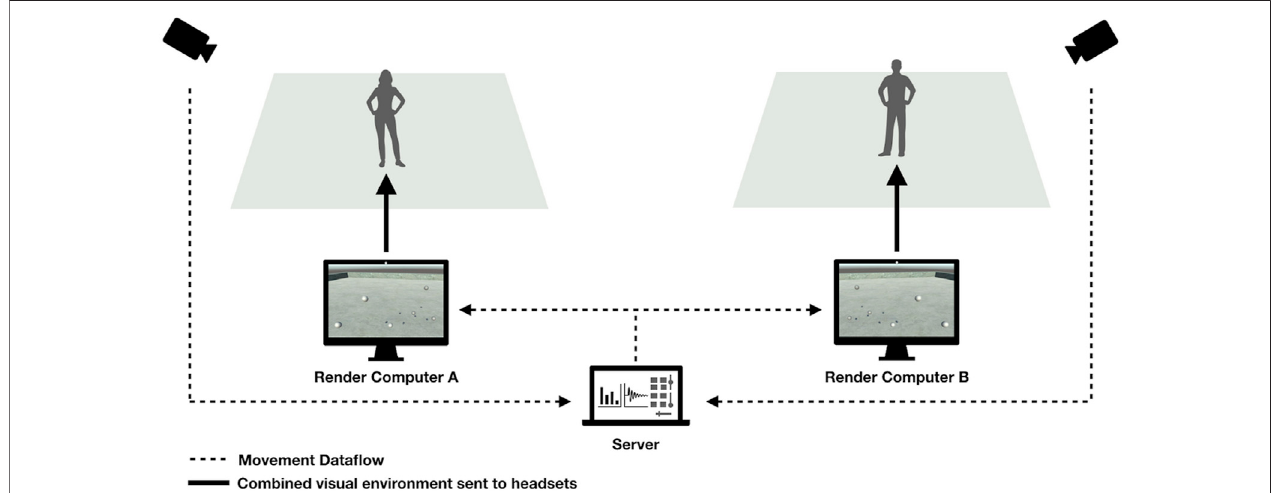
FIGURE 7 | Illustration of the Articulations basic technical setup. Additional “ viewer ” devices can be connected to the server.